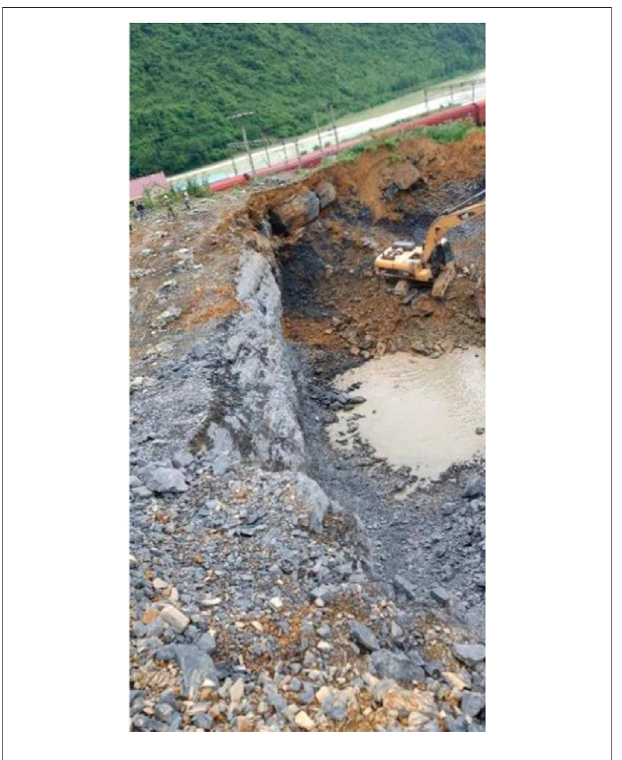
FIGURE 7 | Main rock blasting of reserved rock wall.